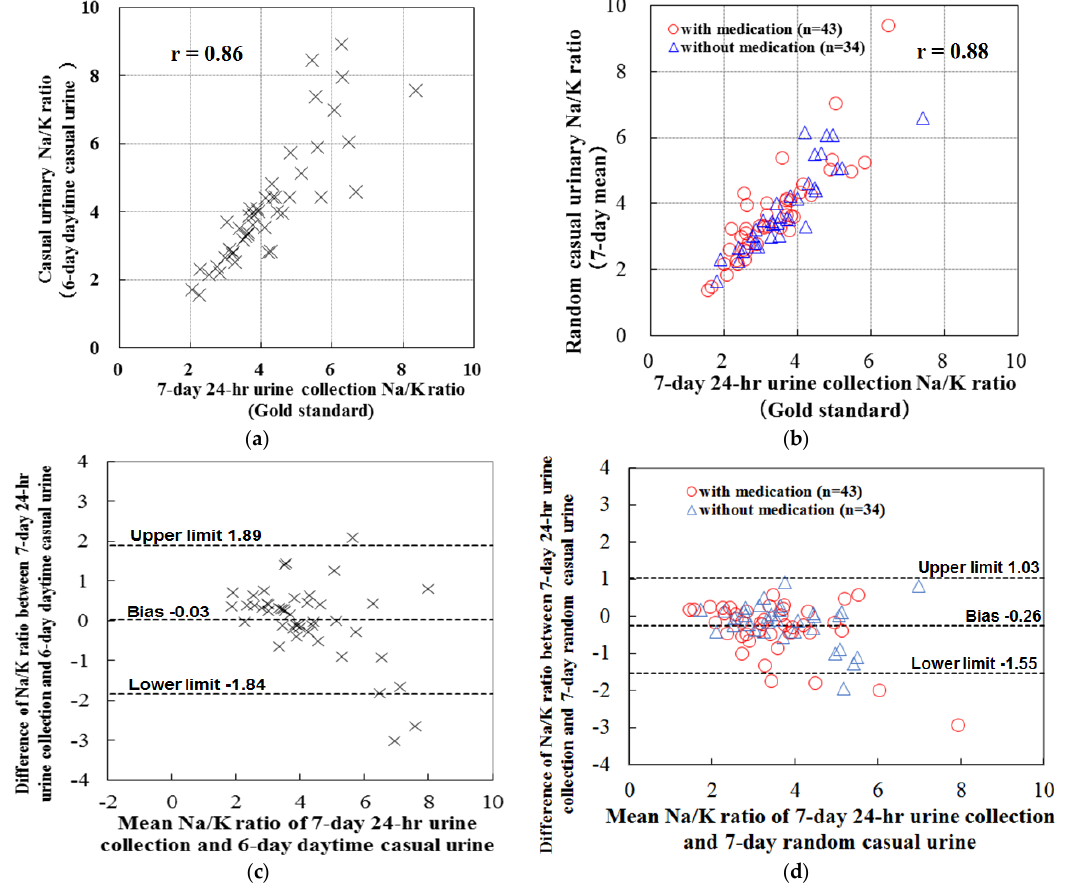
Figure 2. Plots of Na/K ratio of casual urine vs. 24-h urine, and Bland–Altman plots in normotensive and hypertensive individuals (made from data of [67,68]). ( a ) Normotensive individuals (scattered plots, n = 45); ( b ) Hypertensive individuals (scattered plots, n = 77); ( c ) Normotensive individuals (Bland-Altman plots, n = 45); ( d ) Hypertensive individuals (Bland-Altman plots, n = 77).